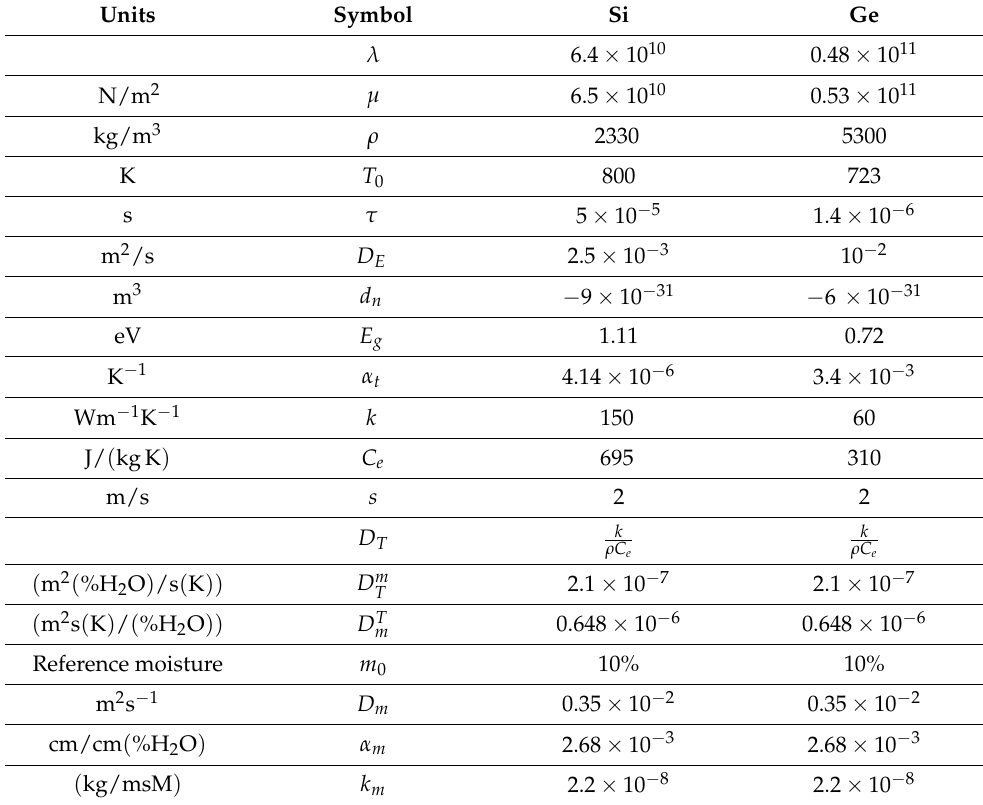
Table 1. Physical parameters of Si and Ge